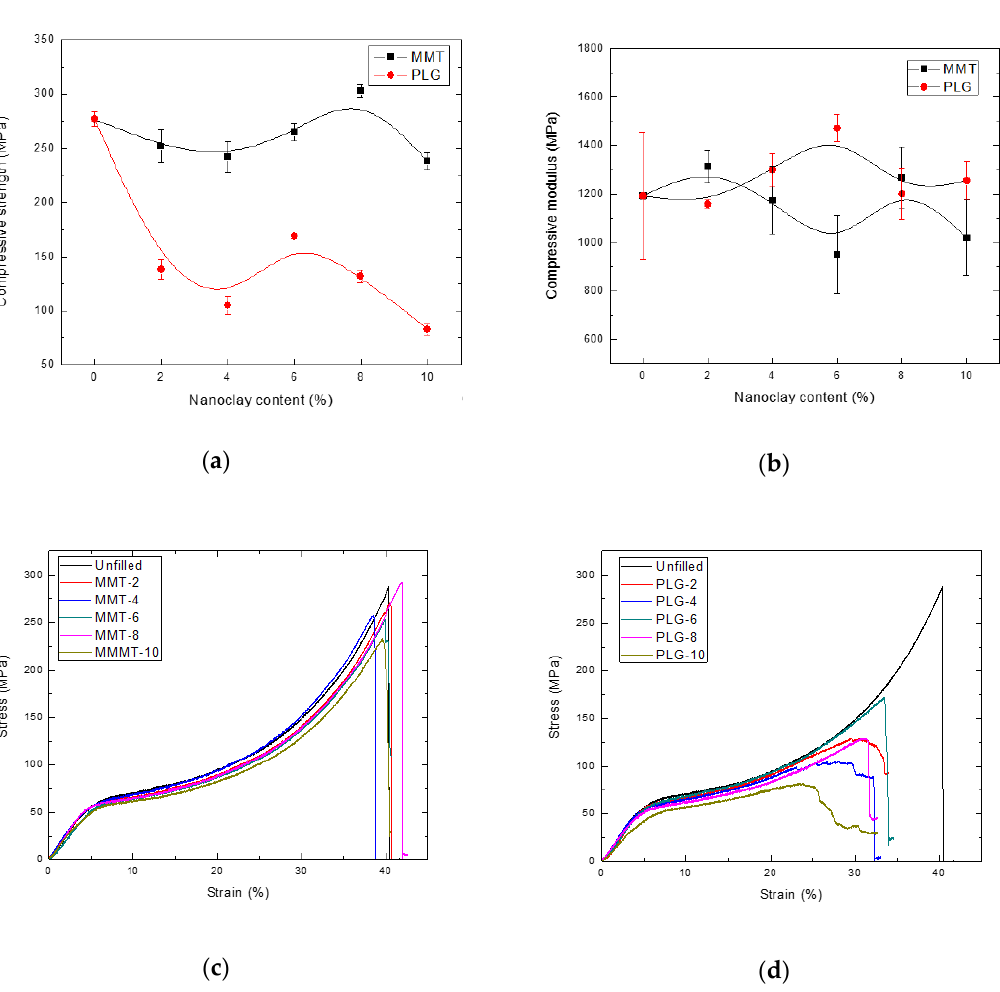
Figure 4. Compressive properties of dental resin composites: ( a ) Strength; ( b ) modulus; ( c ) stress–strain curves for nanocomposites prepared with MMT and ( d ) stress–strain curves for nanocomposites prepared with PLG.